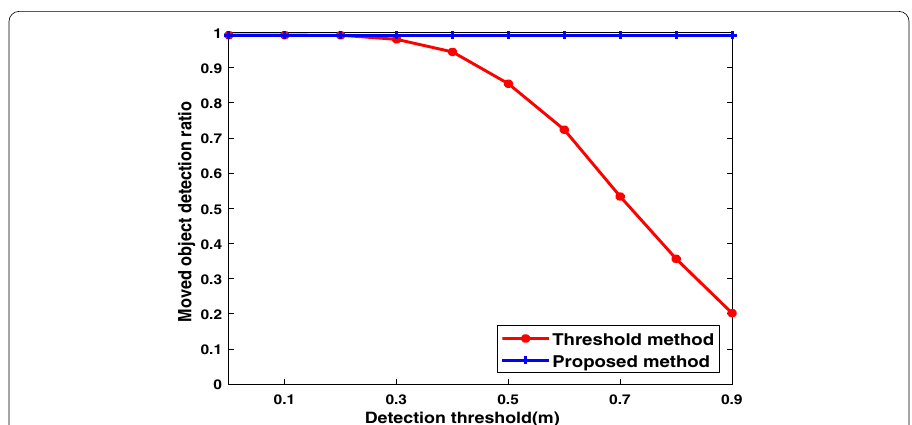
Fig. 6 Detection ratio comparison between our proposed and the threshold method with one displaced object